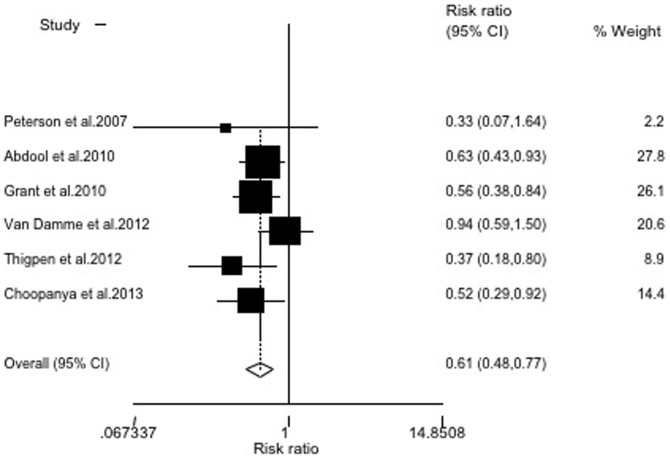
Random-effects model meta-analysis excluding the largest study.Heterogeneity chi-squared = 5.95 (d.f. = 5), P = 0.311; test of RR = 1∶z = 4.12, P<0.001.